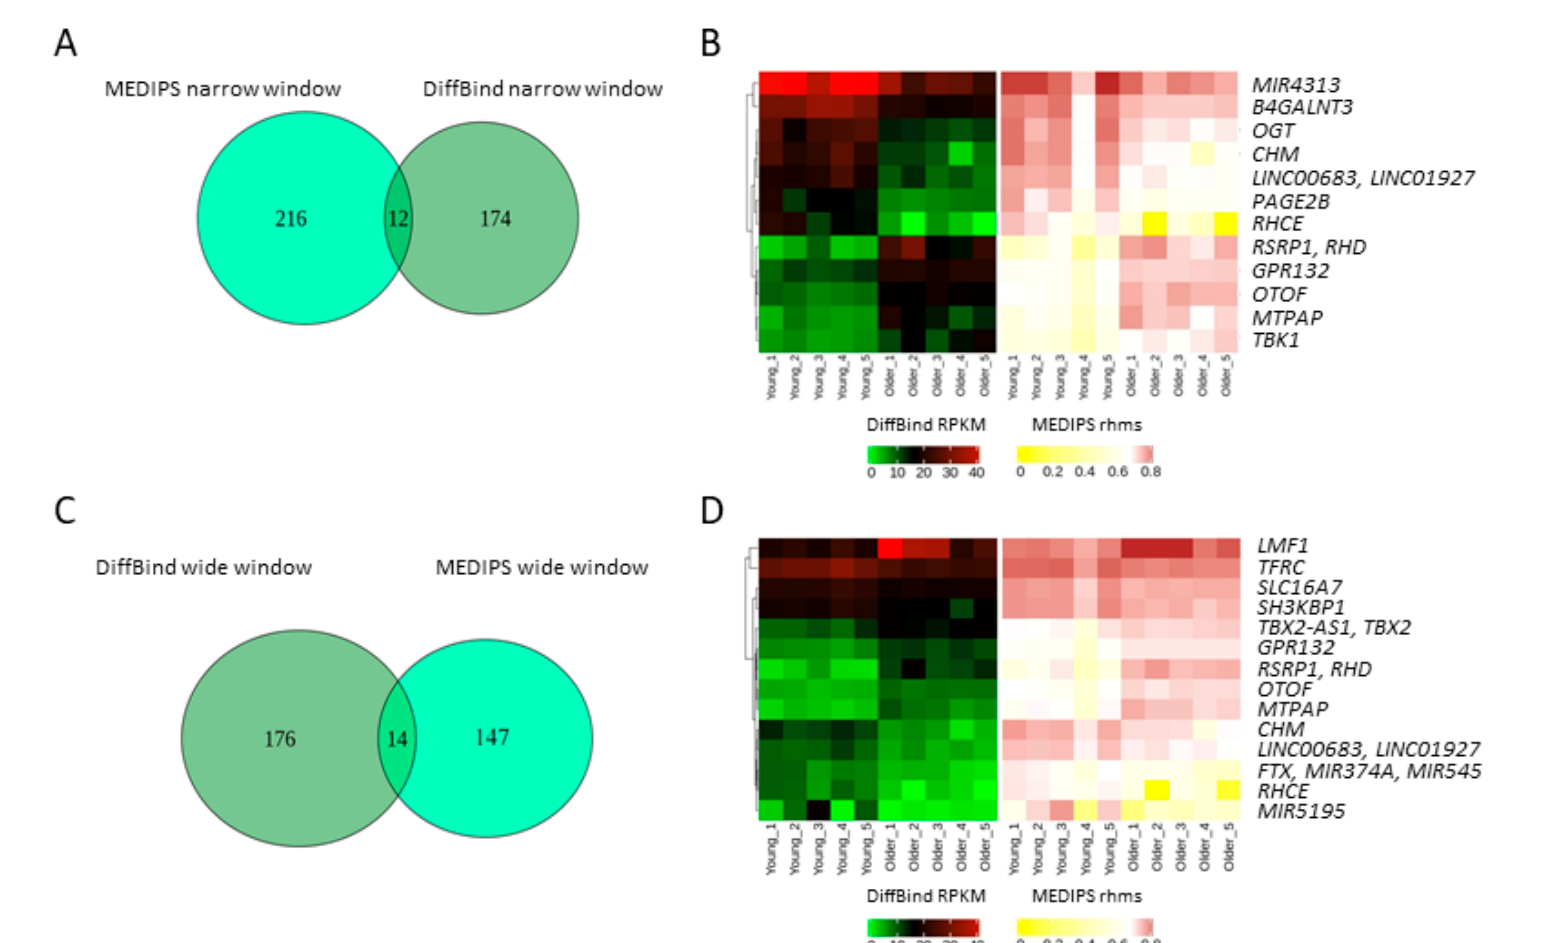
Figure 5. Age-associated differentially hydroxymethylated regions (DHMRs) identified by DiffBind and MEDIPS with the same window size. ( A ) Venn diagram and ( B ) Heatmaps of DHMRs identified by a narrow window analysis. ( C ) Venn diagram and ( D ) Heatmaps of DHMRs identified by a wide window analysis. RPKM: reads per kilobase million, rhms: relative hydroxymethylation score.